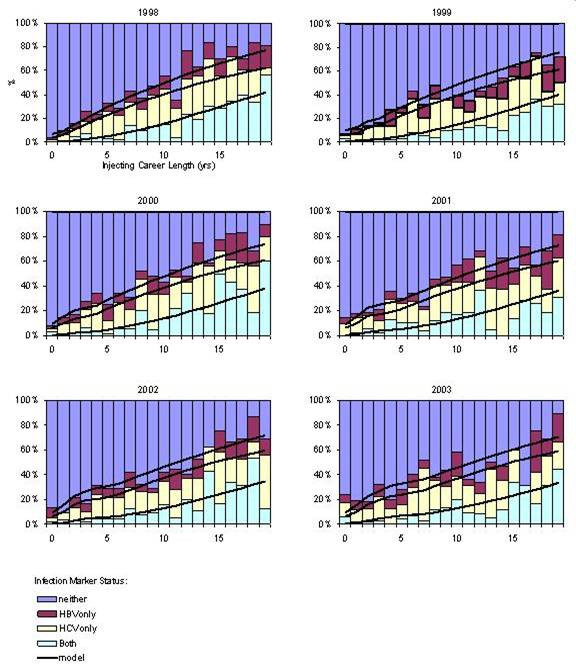
Model fit to data for each survey 1998–2003.